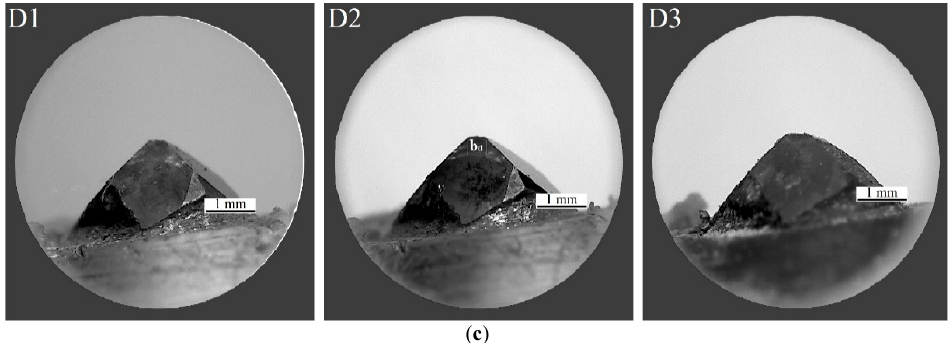
Figure 4. Analysis of the CVD diamond wear state: ( a ) top view; ( b ) wear area trend; and ( c ) side view.